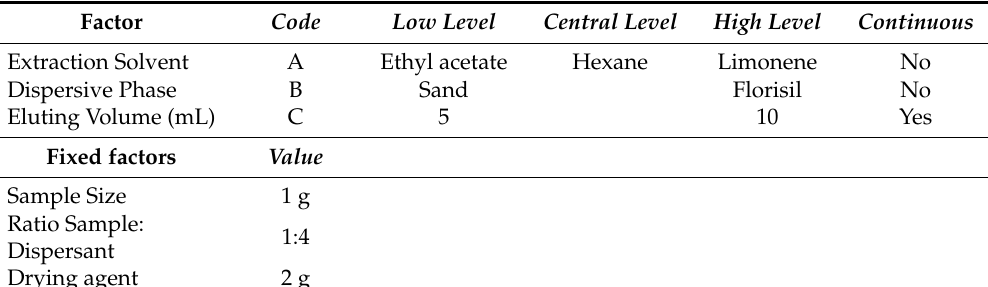
Table 2. Factors and levels considered in the experimental design.